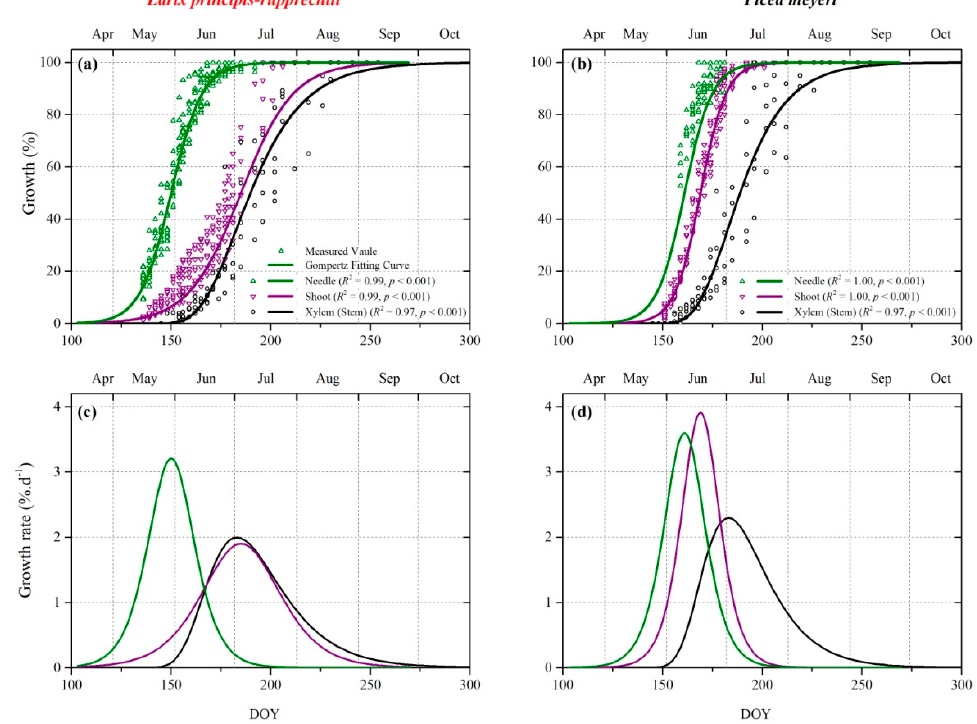
Figure 6. ( a , b ) Intra-annual dynamics of primary growth and secondary growth and ( c,d ) the daily growth rate of larch and spruce. Measured data (scatter) are given as a percent of the final growth and modeled by the Gompertz function (line) (for parameters, see Table S3).